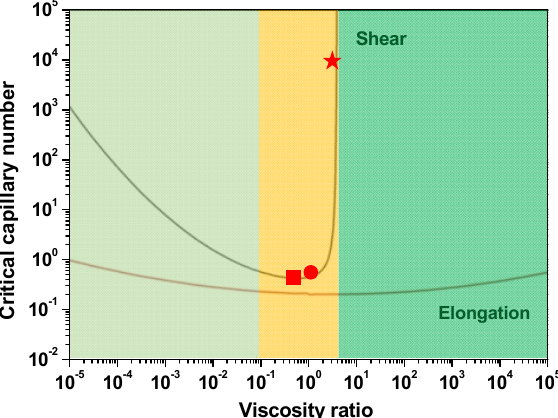
Figure 11. The critical capillary number of dispersed phases as a function of the viscosity ratio of the polymer blend. The red square symbol represents PS1/PP, the red circular symbol represents PS2/PP, the five-star symbol represents PS3/PP.